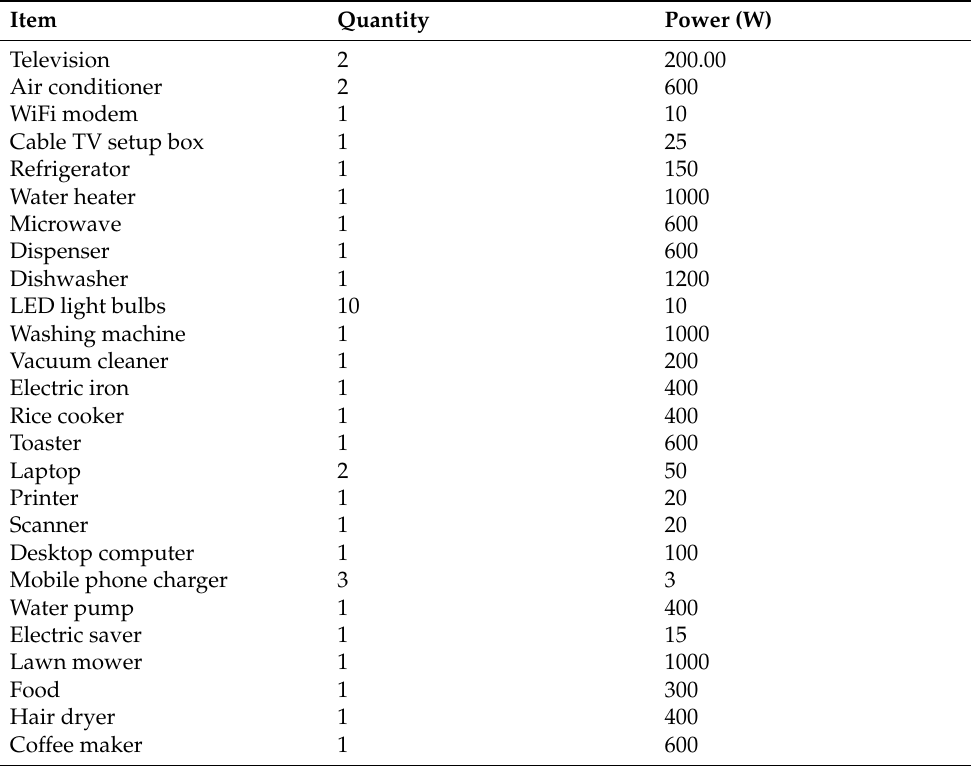
Table 2. Power rating for typical household